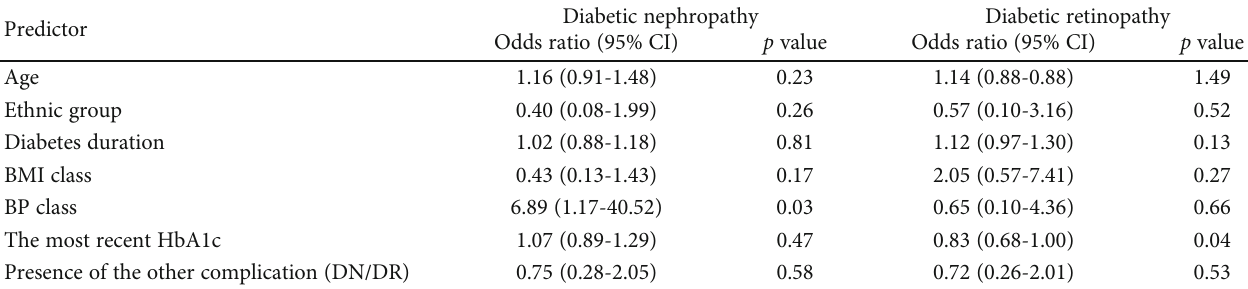
Table 2: Results of logistic regression analysis for risk factors of microvascular